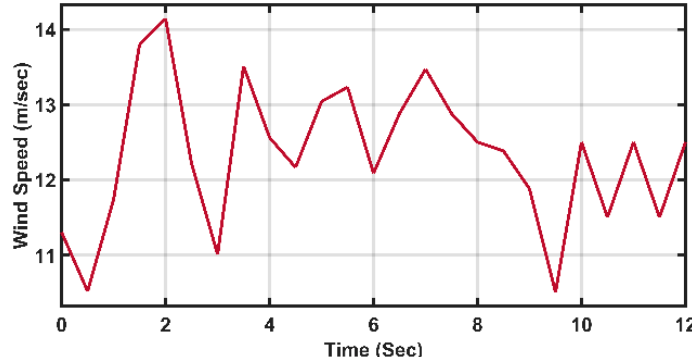
Figure 27. THD percentage of the two controllers under faulty operation.